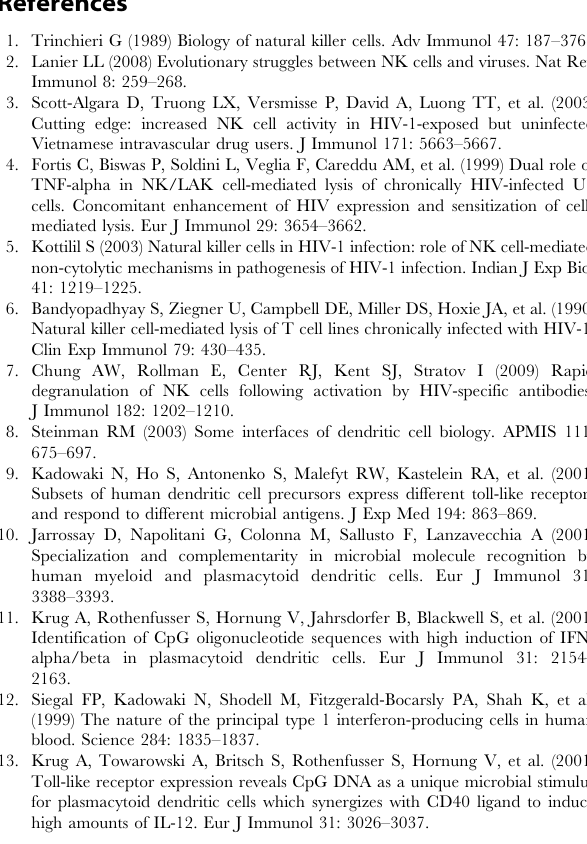
Figure S1 Effect of LPS and CpG DNA on NK cell activation. Purified NK cells were cultured for 24 hours either alone (negative control), or in the presence of CpG DNA, LPS, or phorbol 12-myristate 13-acetate (PMA) and ionomycin (positive control). Cells were harvested and stained for CD69 (A), HLA-DR (B), and CD25 (C). NK cells were also co-incubated with K562 cells for 4 hours and CD107a is shown in (D). Filled Histograms and dotplots represent expression levels by CD56 + CD3- cells from a representative sample. Dotted lines and quadrants indicate nonspecific staining using the appropriate isotype controls. Scatter plots (right) represent cumulative data from all samples and batches of NK cells used in this